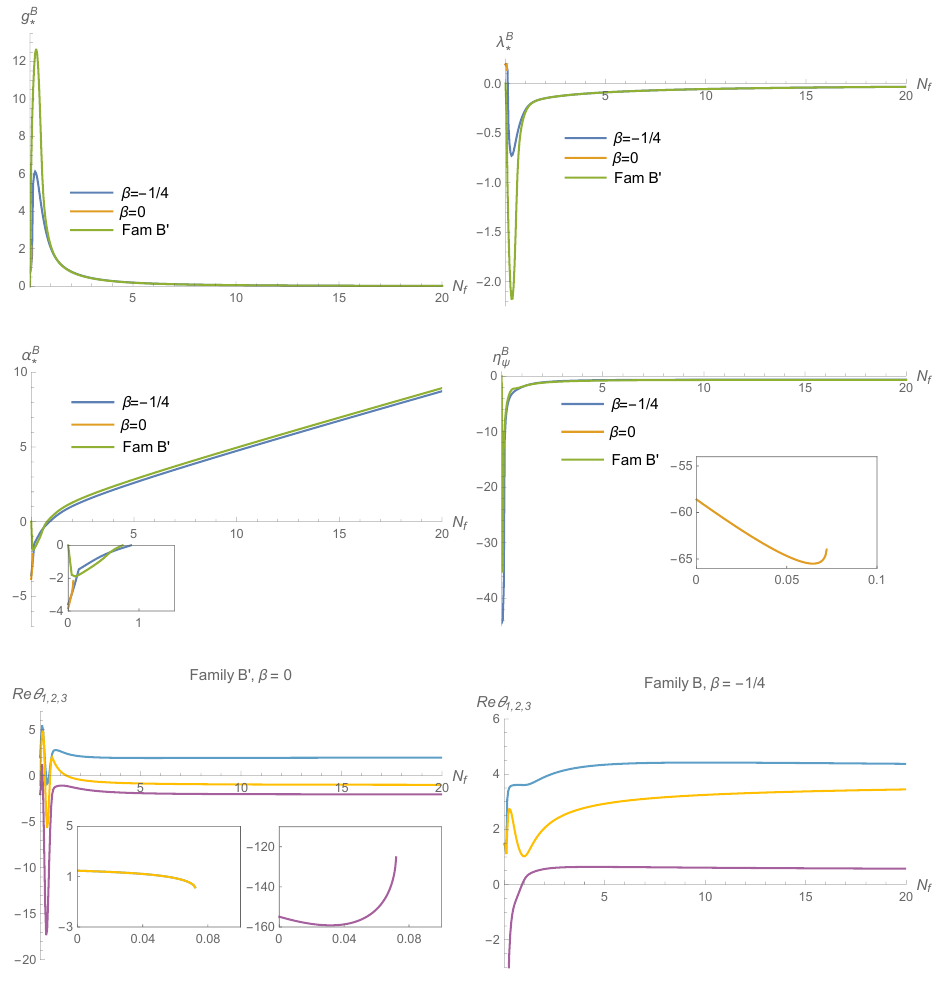
Figure 13. Characteristic properties of Family B obtained from investigating the system Equations (26) and (29) with A 0 = 0. The first three diagrams show the position of the fixed points as a function of N f for β = − 1/4 (blue line) and β = 0 (orange line). NGFP B exists for all values N f for β = − 1/4. For β = 0, Family B moves into the complex plane at N f ≈ 0.6 and does not re-emerge due to the absence of the window (55). Family B ’ continues and is shown as a green line. The fermion anomalous dimension at the fixed points is depicted in the fourth diagram, showing that it is negative and rather large. The stability analysis identifies two UV-attractive and one UV-repulsive stability coefficient for values below the outer edge of (55), indicating that NGFP B is a saddle point in this region. For values beyond this edge, the fixed points function as